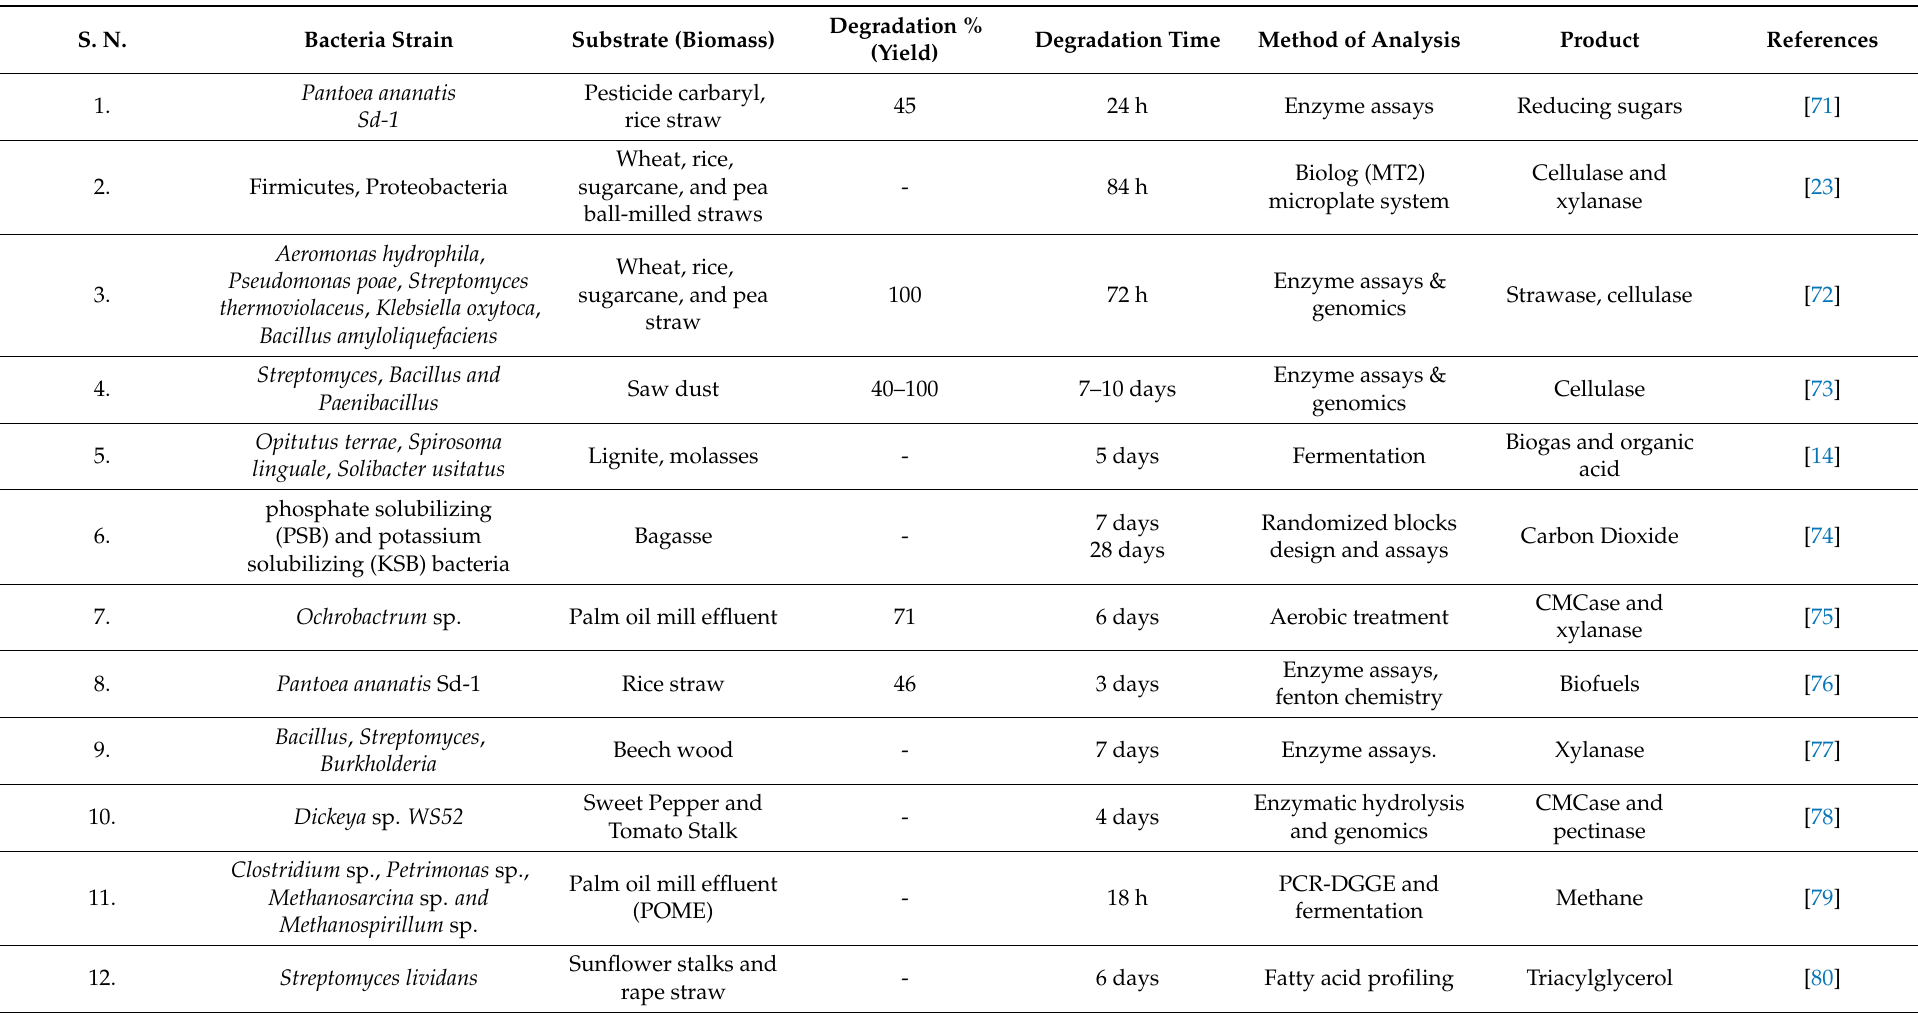
Table 1. Recent bacterial studies using lignocellulose biomass in bio-refinery of various